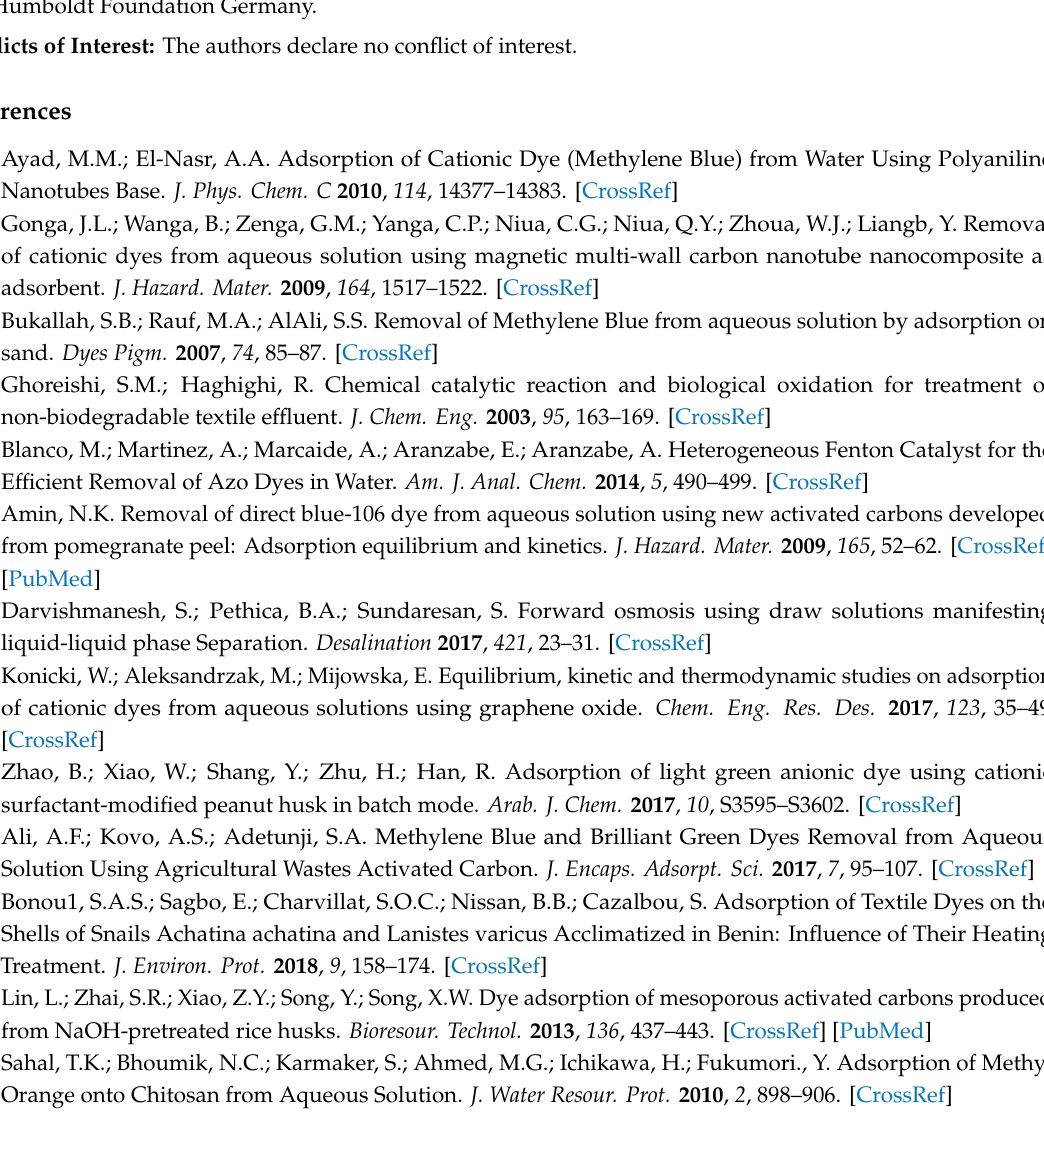
Table S1: Comparison of di ff erent synthesis methods for PANI / iron oxide and their use as adsorbent for removal of various dyes, Table S2: Summery of FTIR absorption